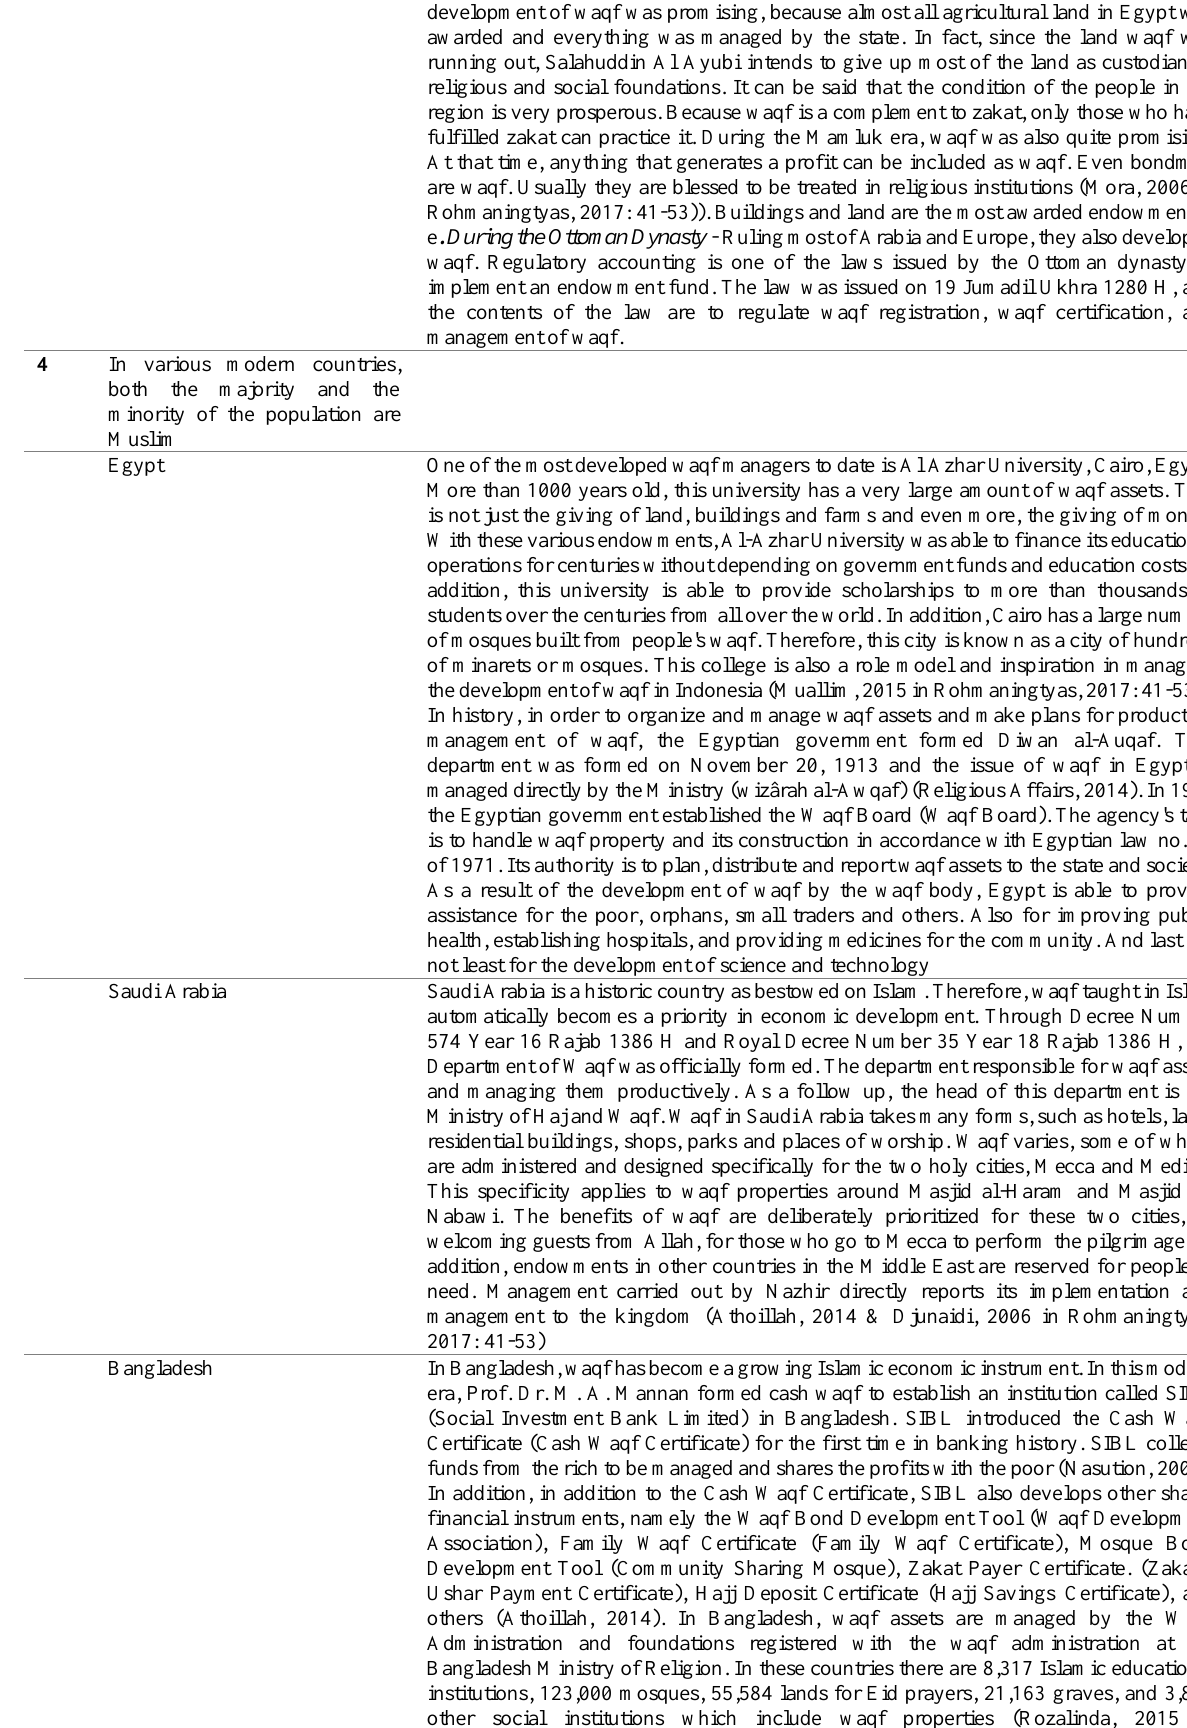
d. During the Ayyubid Dynasty - In Egypt, when the Ayyubids controlled the area, the development of waqf was promising, because almost all agricultural land in Egypt